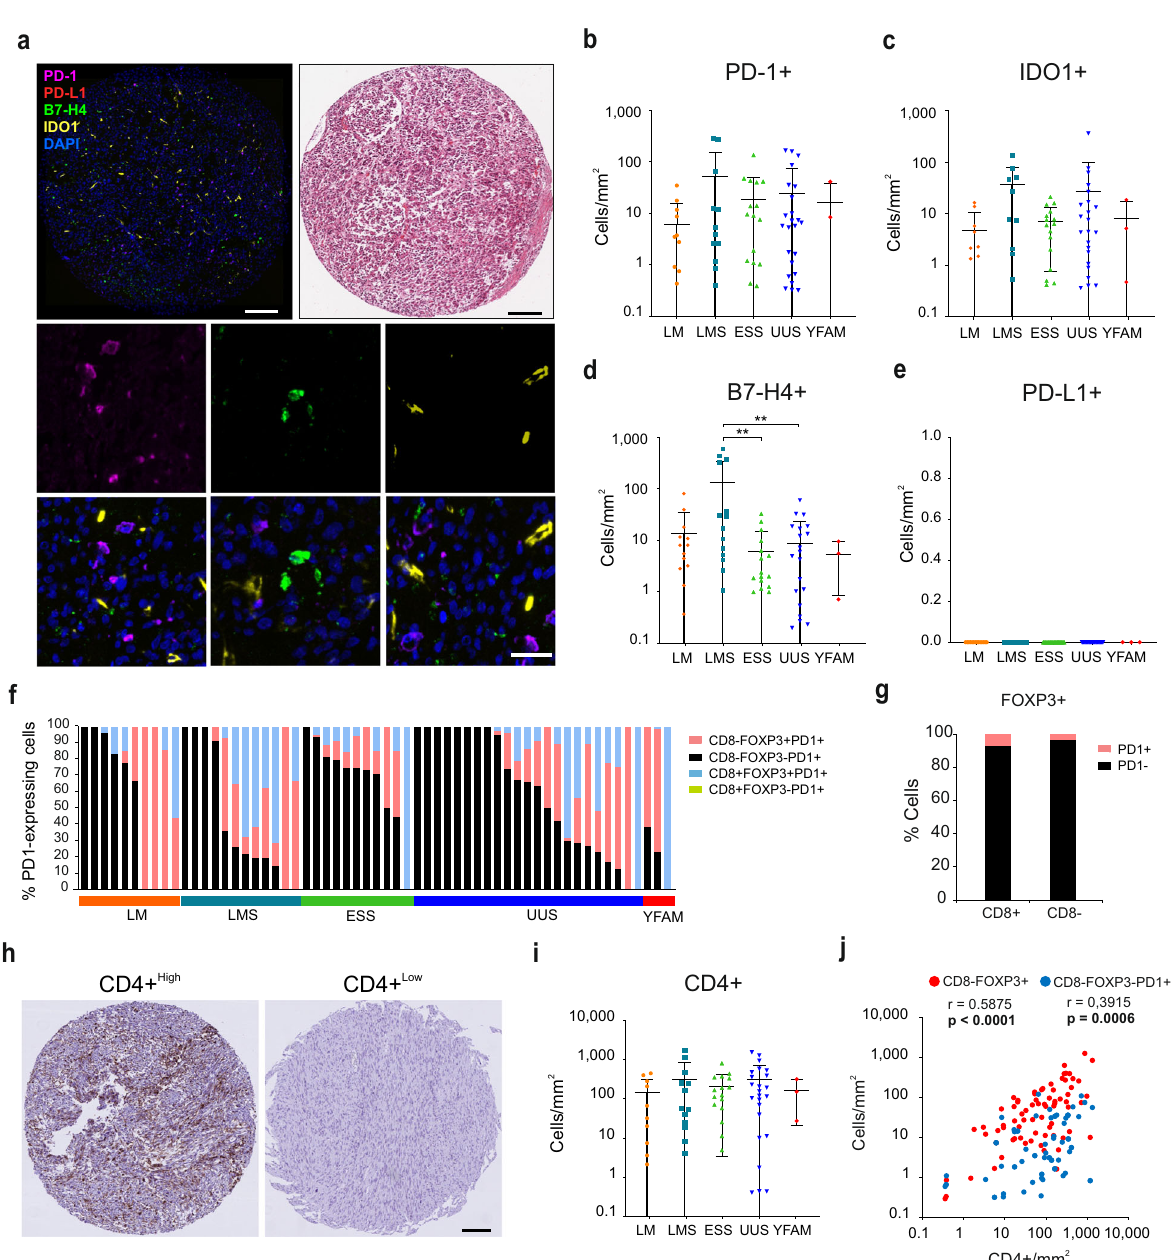
Fig. 2 The expression of immune regulatory proteins (IRPs) is heterogeneous in uterine mesenchymal tumors. a Representative IF staining of an IRPs-expressing tumor (left), its corresponding H&E staining (right), and representative images of cells expressing PD-1, B7-H4, and IDO1 (bottom). Upper scale bars indicate 100 μ m and lower panel scale bar indicates 20 μ m. b – e Quanti fi cation of IRP-expressing cells shows a heterogeneous expression of PD-1 + ( b ), IDO1 + ( c ), B7-H4 + ( d ), whereas PD-L1 is not detected in any tumor group ( e ). f Percentage types of PD-1 expressing cells. g PD-1 expression in FOXP3 + cells. h Representative examples of IHC staining for CD4 + T cells representing high and low in fi ltration tumors. Scale bar indicates 100 μ m. i Quanti fi cation of CD4 + T cell density shows heterogeneity in CD4 + expression in all tumor types. j Scatter plot shows the signi fi cant correlation between IHC stained CD4 + and IF stained CD8-FOXP3 + and CD8-FOXP3-PD-1 + T cells ( r indicates Pearson correlation coef fi cient). Plots indicate average ± s.d. Signi fi cance is indicated as **( P <